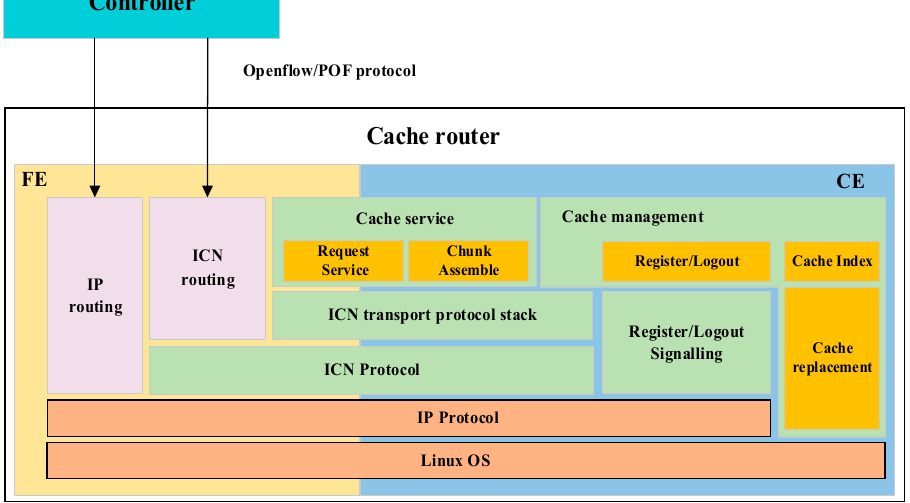
Figure 3. Software architecture of the proposed information-centric networking (ICN) router.